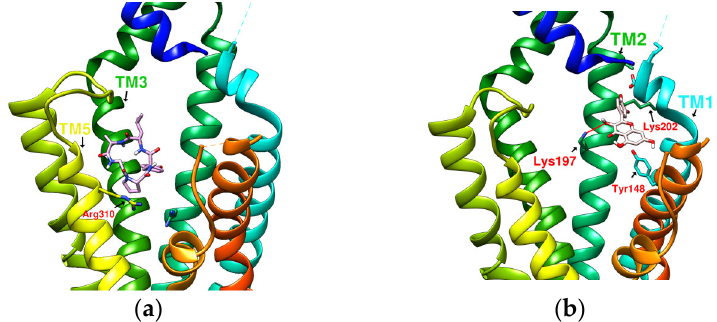
Figure 5. ( a ) PA/GLP-1R (−8.1 kcal/mol), ( b ) Quercetin/GLP-1R (−7.8 kcal/mol).